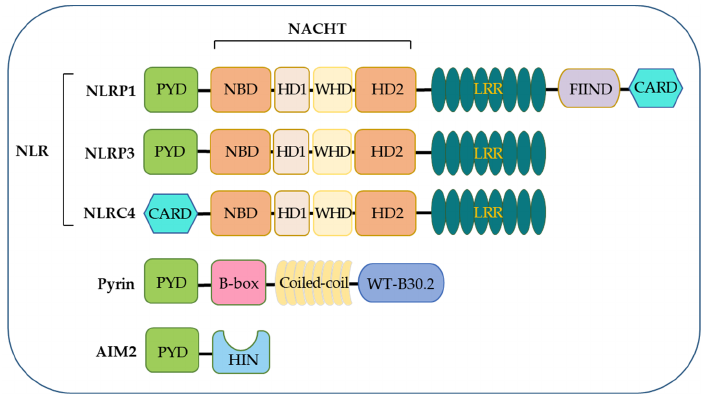
Figure 1. Domain architecture of canonical inflammasome sensors. Overview and alignment of the distinct domains for sensors that initiate canonical inflammasome